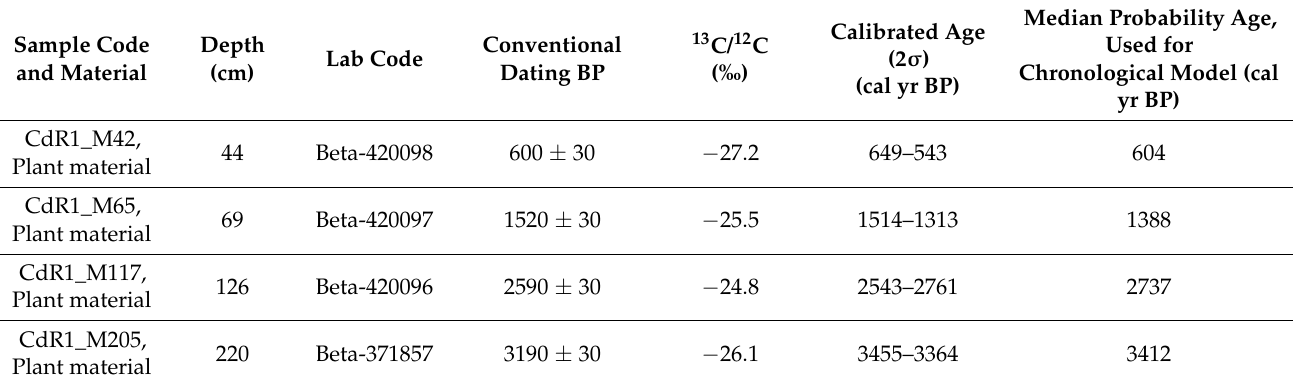
Table 1. Chronological data and calibrated ages for the Clots de Rialba record (CdR1). The IntCal20 Northern Hemisphere radiocarbon age calibration curve was used to calibrate the radiocarbon dates